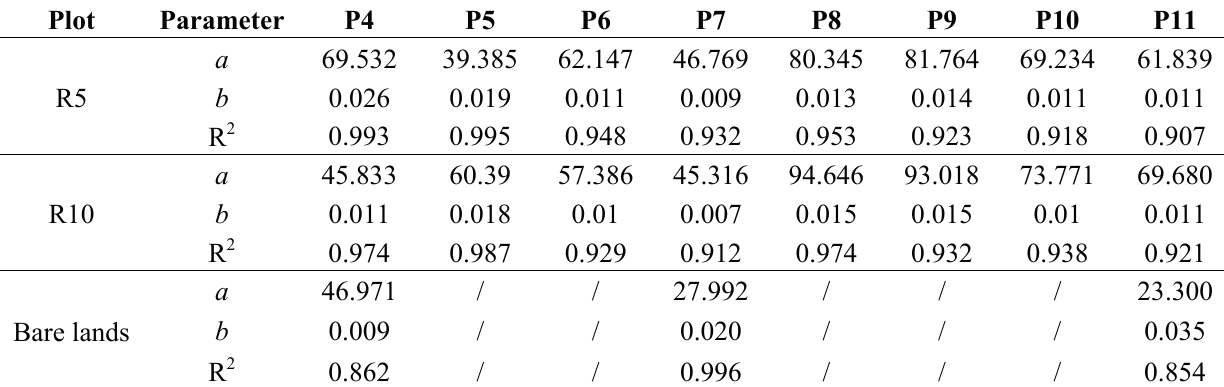
Table 4. a and b values and fitting degree comparisons in the curve fitting equation of interflow